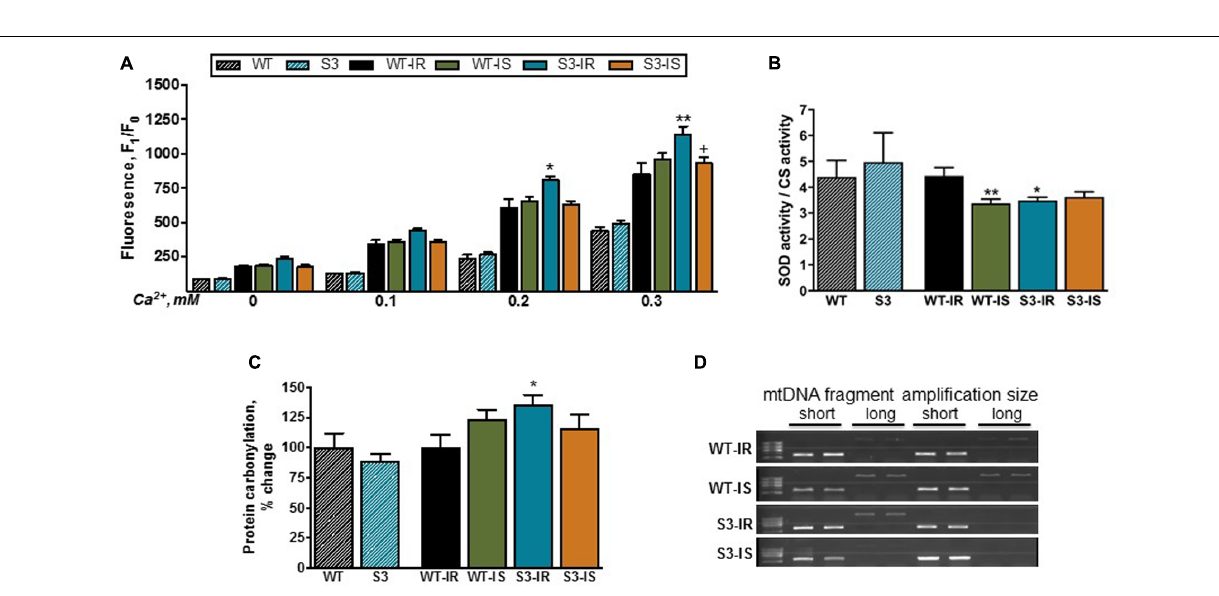
FIGURE 5 | Basal and Ca 2 + -stimulated ROS production (A) , total SOD activity (B) , protein oxidation (C) , and mtDNA lesions (D) in mitochondria of WT and SIRT3 − / − hearts. ROS production (A) was assessed by measurement of resorufin fluorescence, the Amplex Red oxidation product. ROS production was stimulated by the repeated addition of Ca 2 + to mitochondrial suspension. Total SOD activity (B) was normalized to the CS activity. Protein oxidation (C) was measured by dinitrophenylhydrazine derivatization to detect protein carbonyls in mitochondria, and normalized to the WT group (for S3) or WT-IR group (WT-IS, S3-IR, and S3-IS). mtDNA damage (D) was assessed by relative amplification of a long (15 kbp) to a short (2 kpb) DNA fragment (Damage to mtDNA reduces amplification of the long fragment). Groups are given in Section “Materials and Methods” (see Ex vivo Model of IR). ∗ P < 0.05, ∗∗ P < 0.001 vs. WT-IR; + P < 0.05 ++ P < 0.01 vs. S3-IR. n = 4–7 per